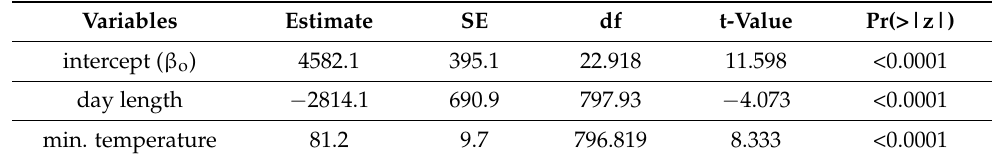
Table 4. Model estimates and significance of the environmental variables predicting wildcat